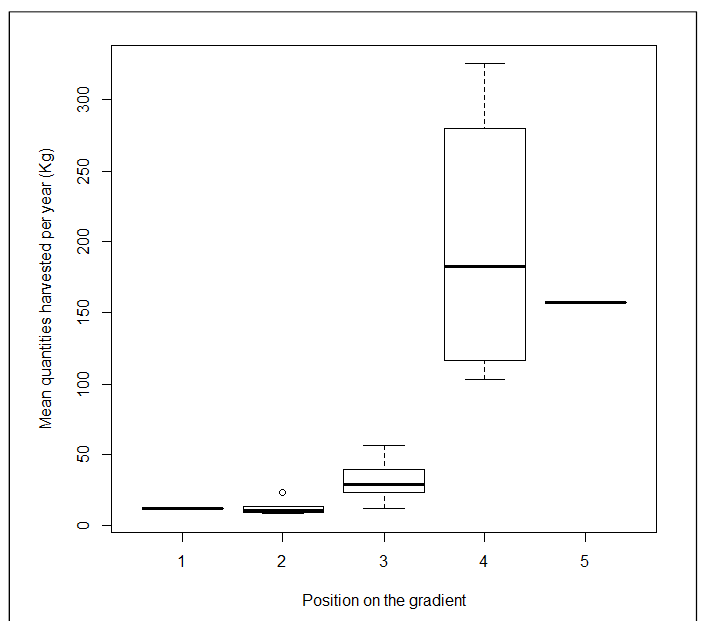
Figure 6. Comparison of Gardeners’ Self-assessment of the Importance of the Garden in their Food Supply and the Quantities Harvested, Indicating Position on the